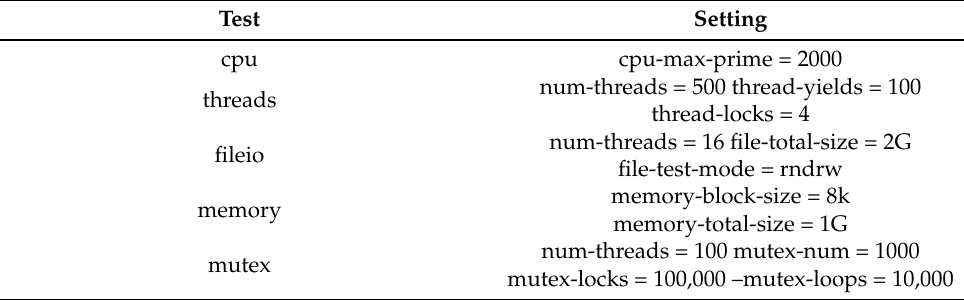
Table 8. Configuration settings of sysbench .